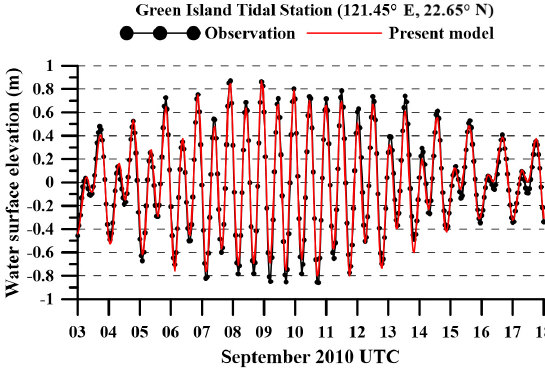
Figure 5. Historical water surface elevation at the Green Island tidal station.